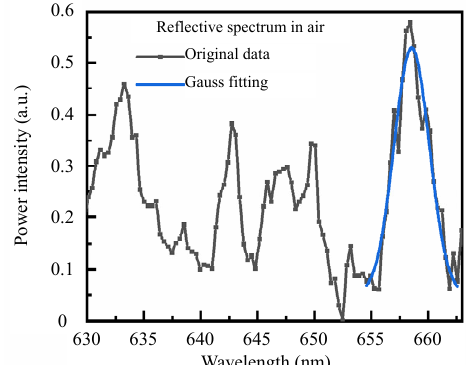
Fig. 4 Multiplex sharp reflection peaks in ZnO-nanograting sensor.